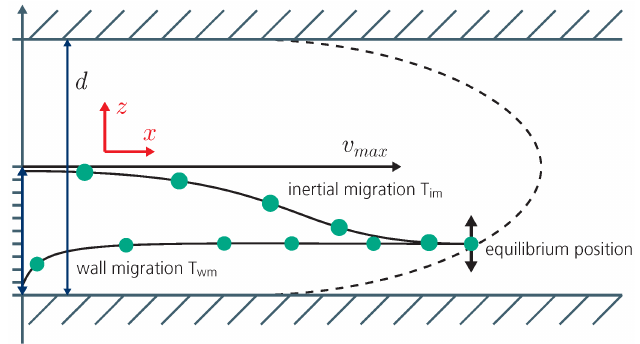
Figure 8. Longitudinal section of the microfluidic channel with a parabolic flow profile (dashed line). Two competing forces act on a suspended particle. The viscous lift force